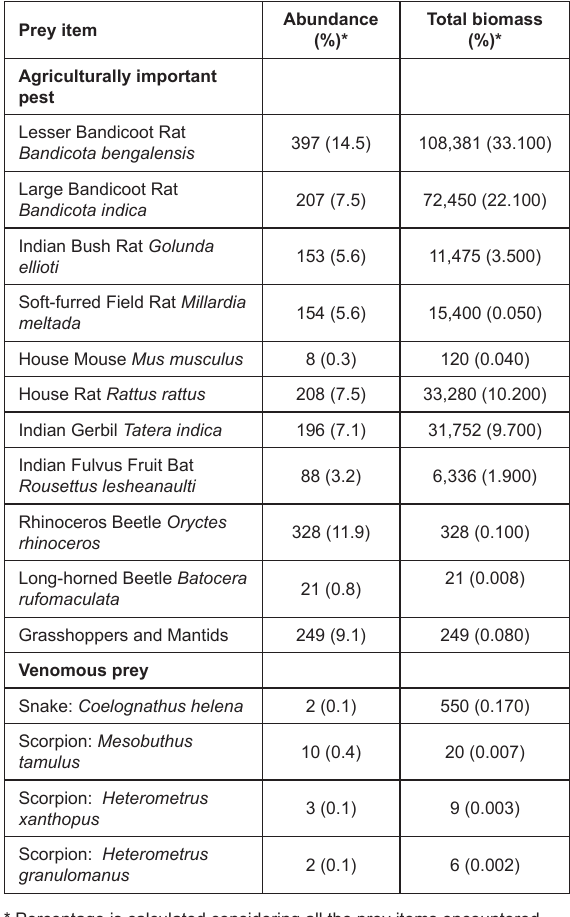
Table 2. Abundance and total biomass of agriculturally important pests and other prey venomous for man in the diet of the Indian Eagle